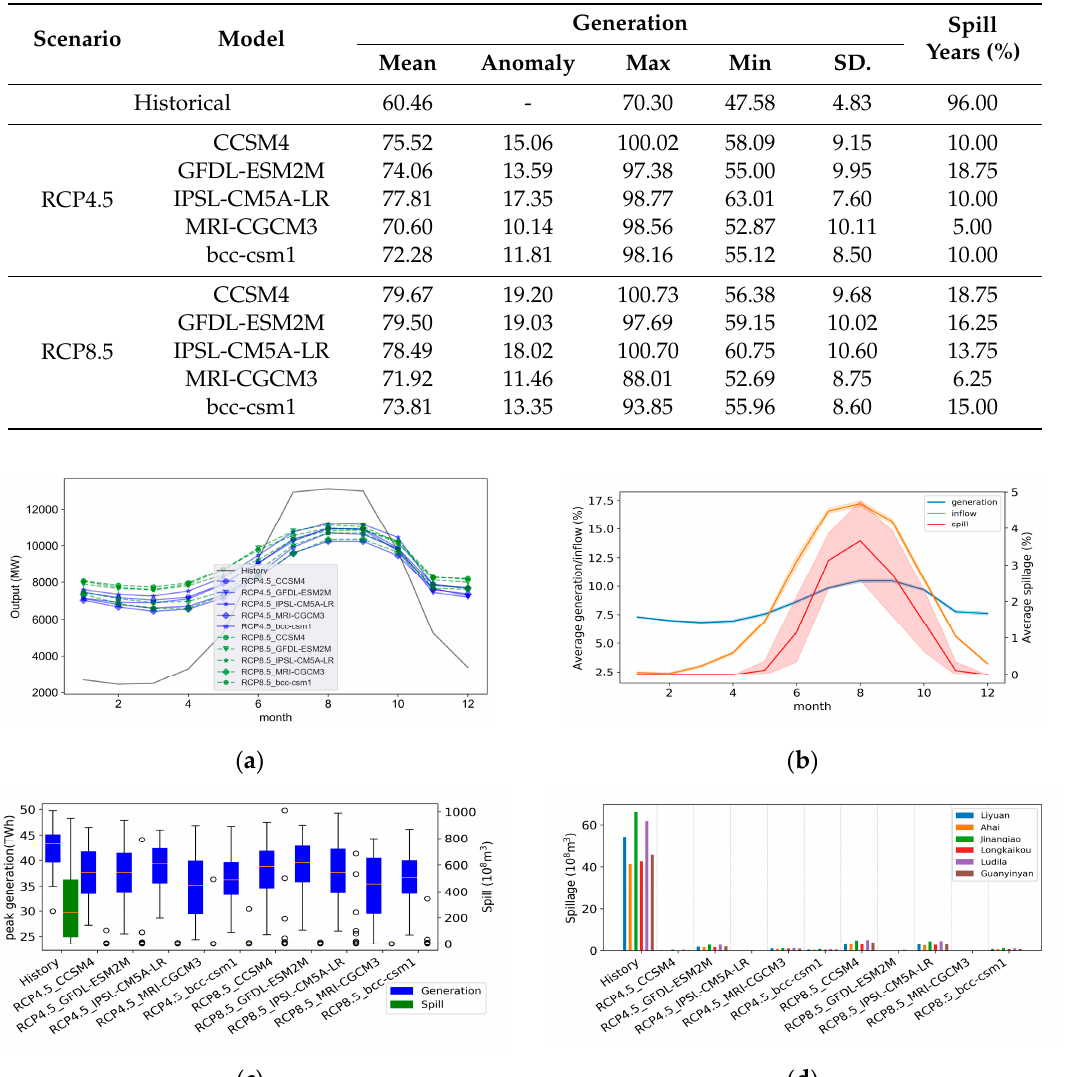
Table 7. JSCHS annual generation statistics with Longpan commissioned (omits generation of Longpan hydropower station to aid comparison with Tables 5 and 6, unit: TWh).